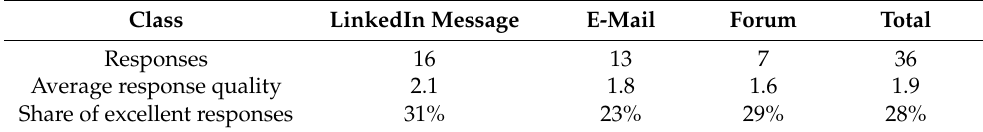
Table 3. Overview of response quality results grouped by means of